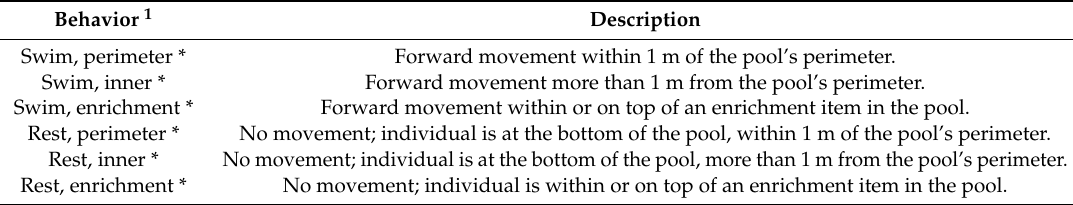
Table A11. Stingray and shark ethogram, with behaviors of focus indicated with an asterisk (*). Behavior 1 Description Swim, perimeter * Forward movement within 1 m of the pool’s perimeter. Swim, inner * Forward movement more than 1 m from the pool’s perimeter. Forward movement within or on top of an enrichment item in the